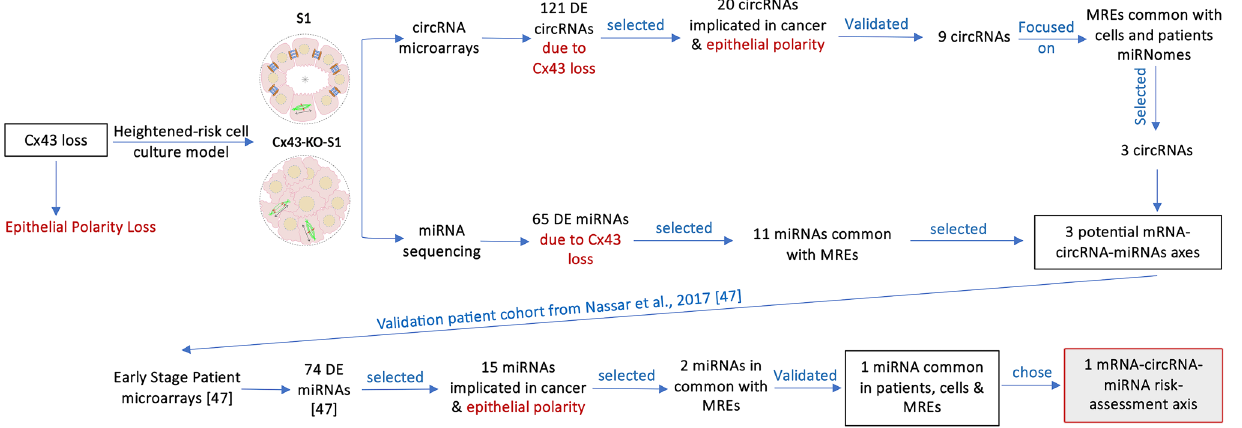
Figure 1. A graphical abstract summarizing the methodology used to select Cx43/has_circ_0077755/miR- 182 as the only validated risk-assessment axis for breast cancer initiation. Using the circRNA microarrays and miRNA sequencing results of Cx43-KO-S1 compared to S1 cells and focusing mainly only on Cx43 loss (and hence epithelial polarity loss) and on the sponging activity of circRNAs to miRNAs, three axes were predicted for breast cancer risk-assessment. After using a validation early-stage young breast cancer patient cohort as published in Nassar et al. 47 , the list was narrowed down to only Cx43/has_circ_0077755/miR-182 axis. MREs refer to miRNA response elements, predicted to be “sponged” by the significant circRNAs based on Arraystar’s miRNA target prediction software 52,53